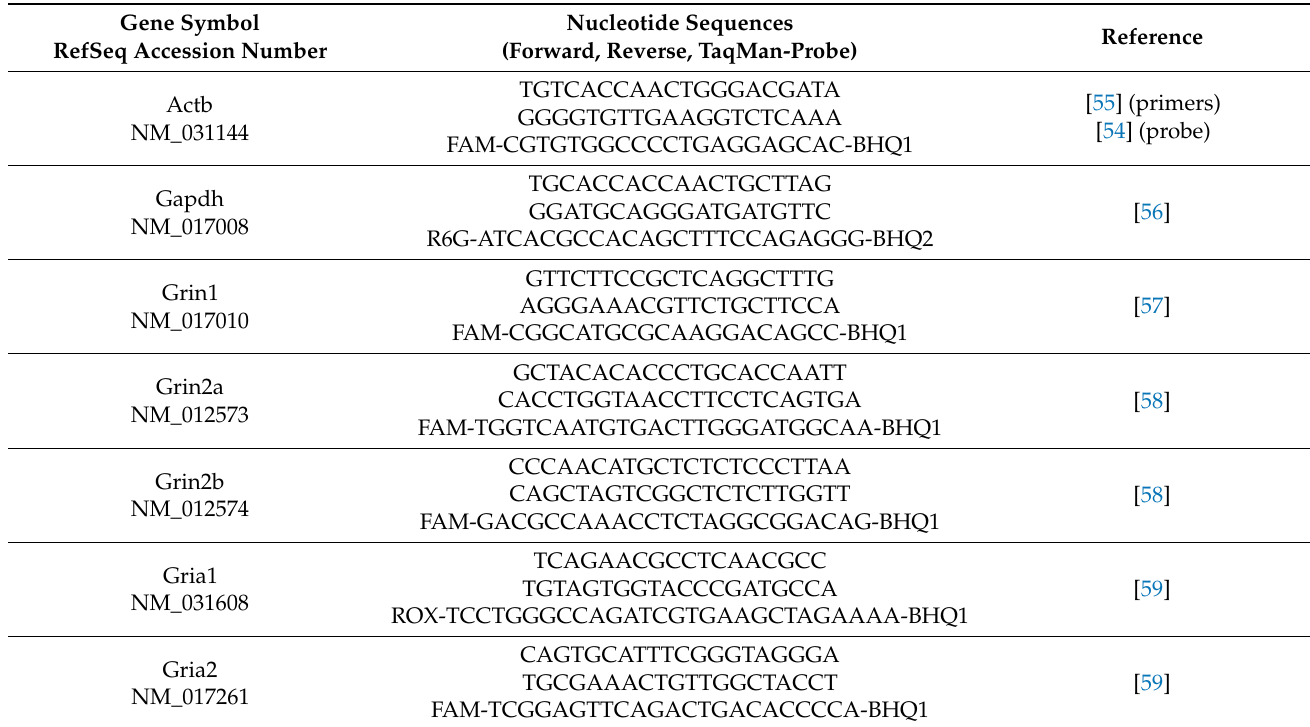
Table 1. Primers and probes used in